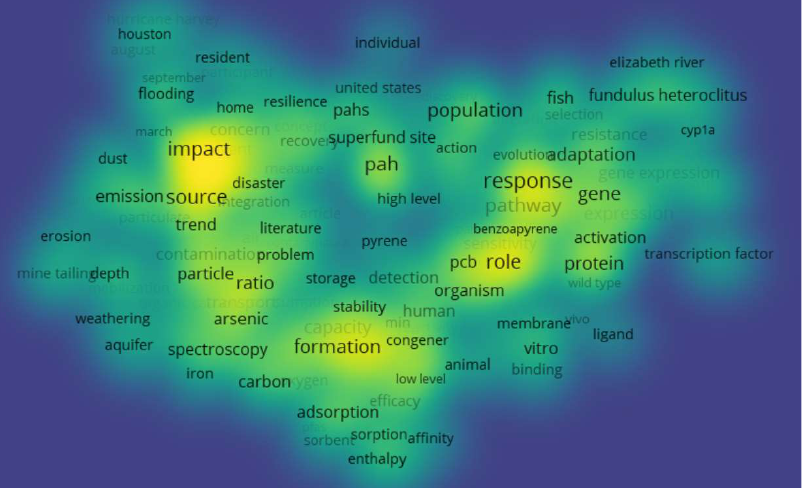
Figure 5. Density map of title and abstract keywords for all SRP grantee publications related to climate change (all time) generated in VOSviewer. A larger font size and yellow color indicate a higher frequency of keyword occurrence. The distances between each of the keywords indicate the relatedness of the research topics.